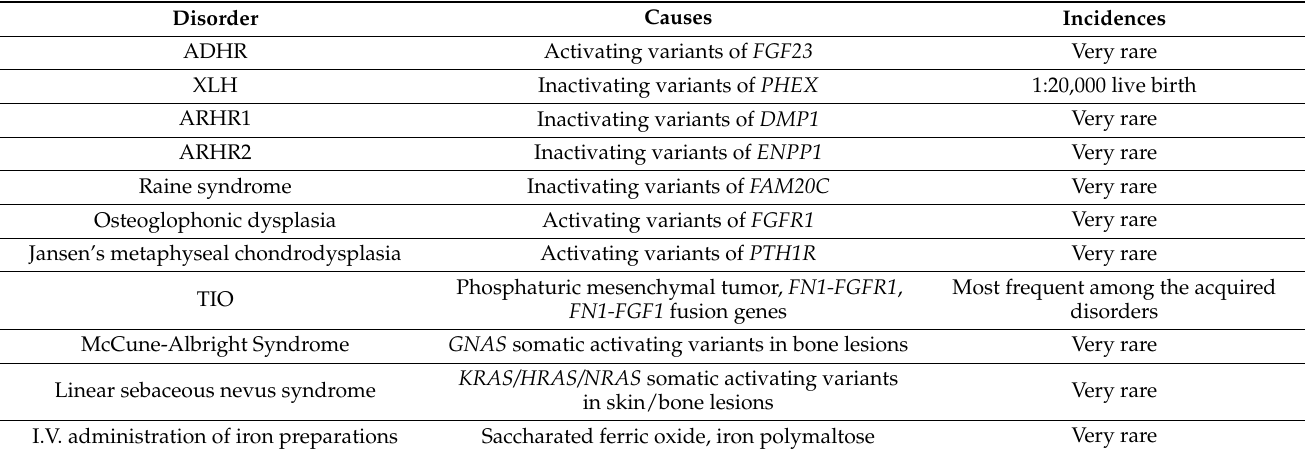
Table 1. FGF23-related hypophosphatemic diseases and their